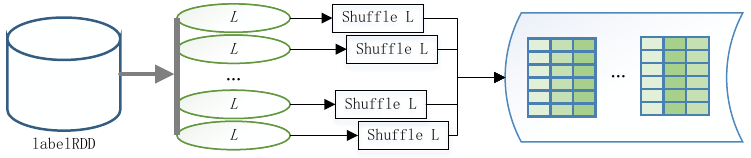
Figure 6. Parallel label